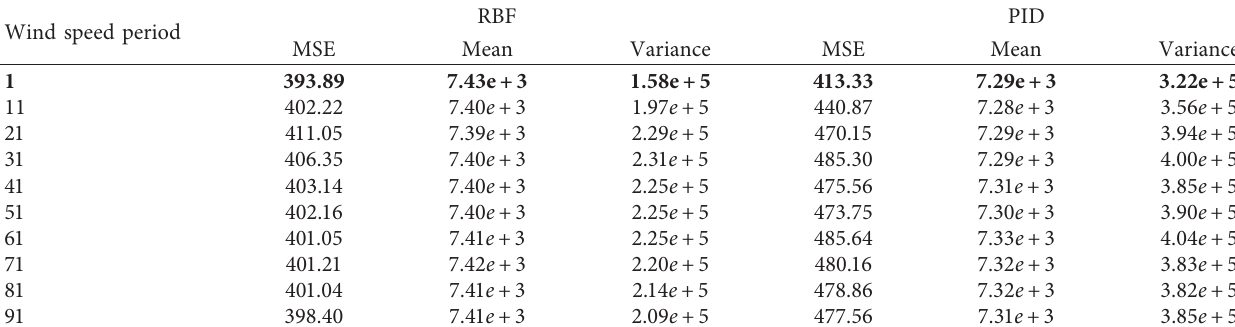
Figure 12: Influence of σ in the MSE for different number of neurons. Table 3: MSE, output power mean, and variance for different periods of sinusoidal wind speed.